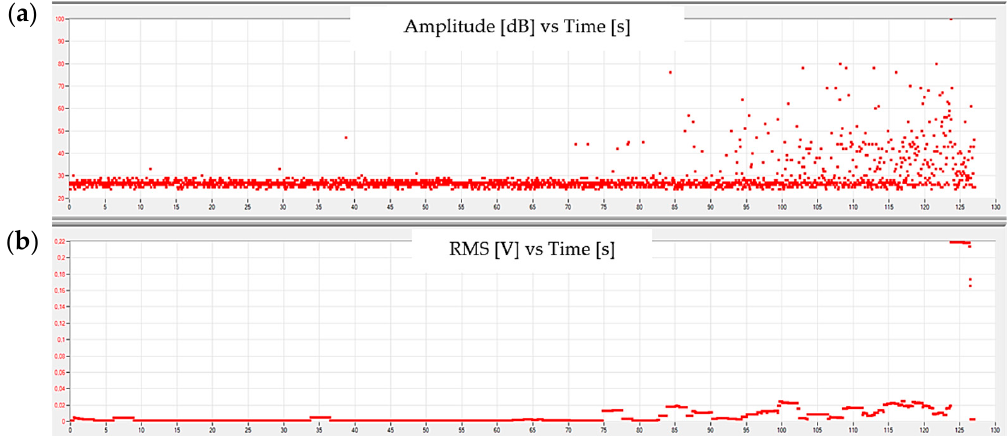
Figure 7. Sample graphs showing the change in ( a ) amplitude and ( b ) RMS of the signal as a function of time for a composite sample.